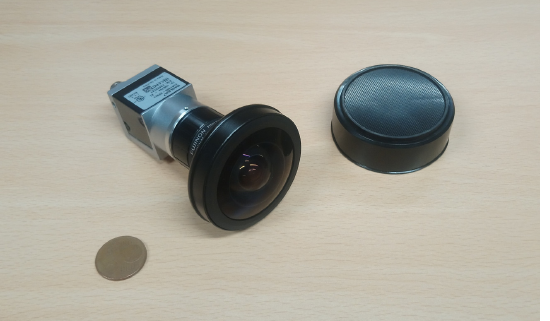
Figure 1. Basler ace acA2040-120uc color camera equipped with a fish eye lens utilized in our experiments. It is positioned next to a EUR 0.05 coin.